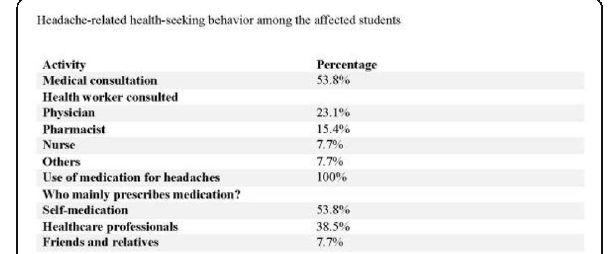
Fig. 2 (abstract P0238). See text for